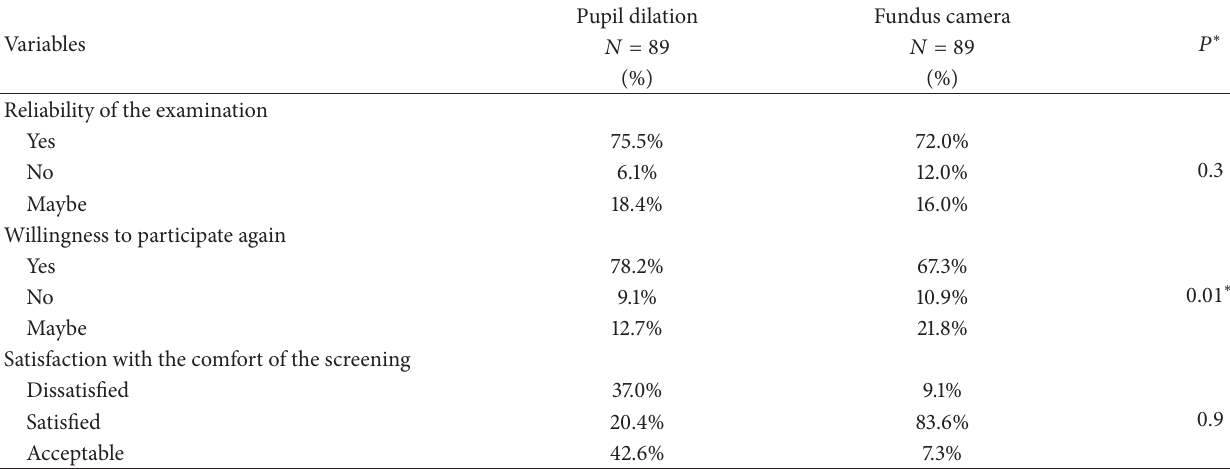
Table 3: Reliability, satisfaction, and willingness to participate again in a classical or fundus camera examination for DR screening.